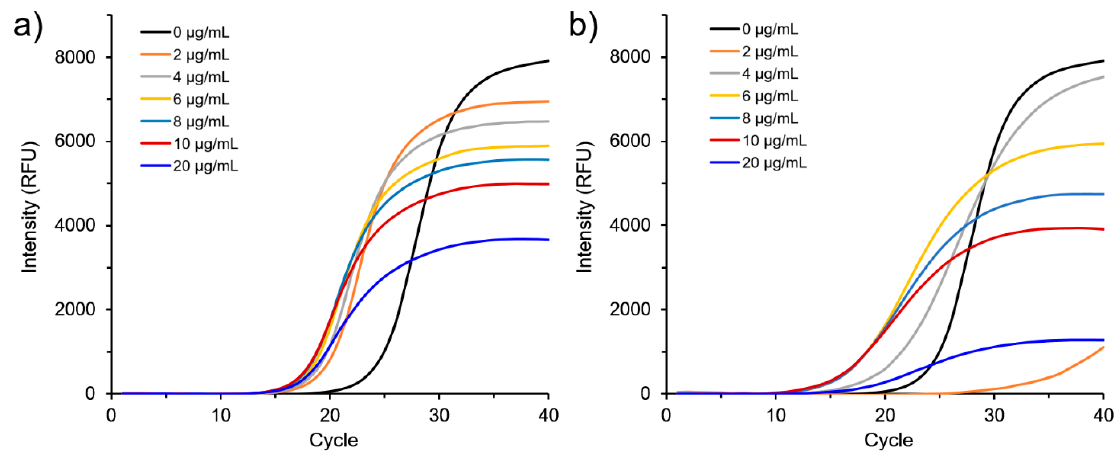
Figure 2. Effect of GO-AuNPs concentrations on nano-PCR using pan-type primers. Quantitation of FMDV O-type ( a ) and FMDV A-type ( b ) gene amplification.